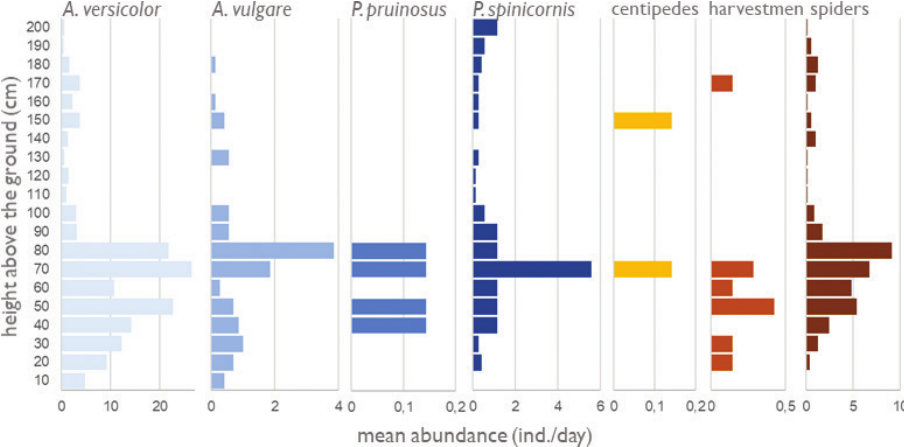
Figure 4. Vertical distribution of terrestrial isopod species and predators on the wall per day in 90-min